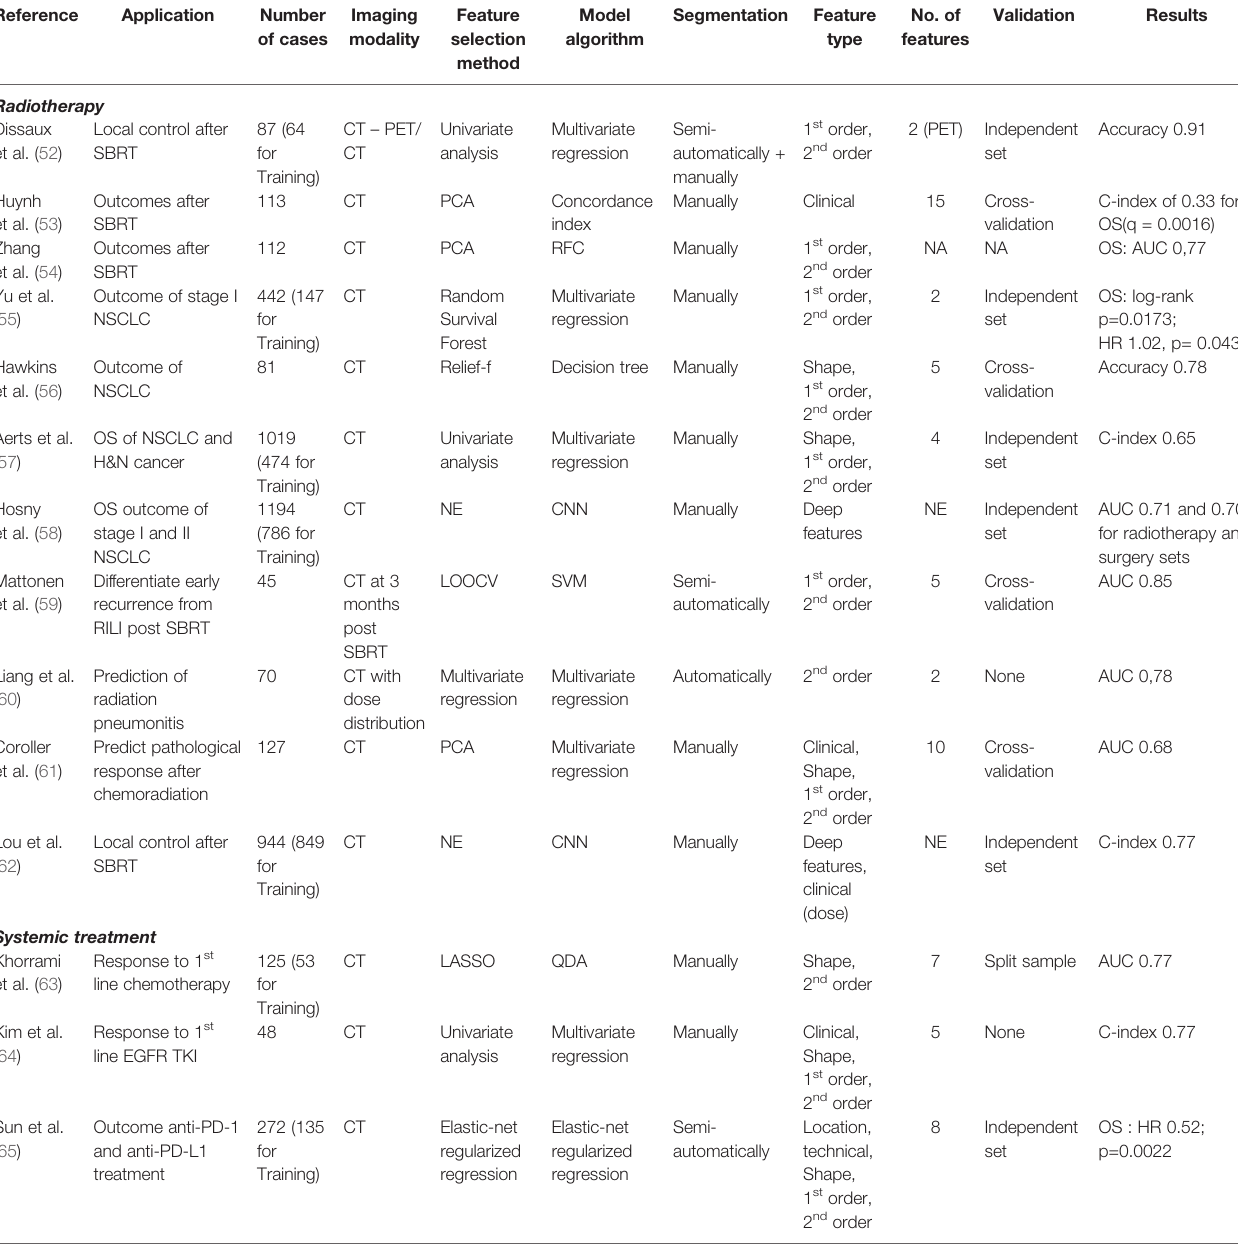
AUC, area under the curve; CNN, convolutional neural network; CT, computed tomography; LASSO, least absolute shrinkage and selection operator; LOOCV, leave-one-out cross validation; NE, not evaluable; OS, overall survival; PCA, Principle Component Analysis; PET, positron emission tomography; QDA, Quadratic discriminant analysis; RFC, Random Forest Classi fi er; SVM, support vector